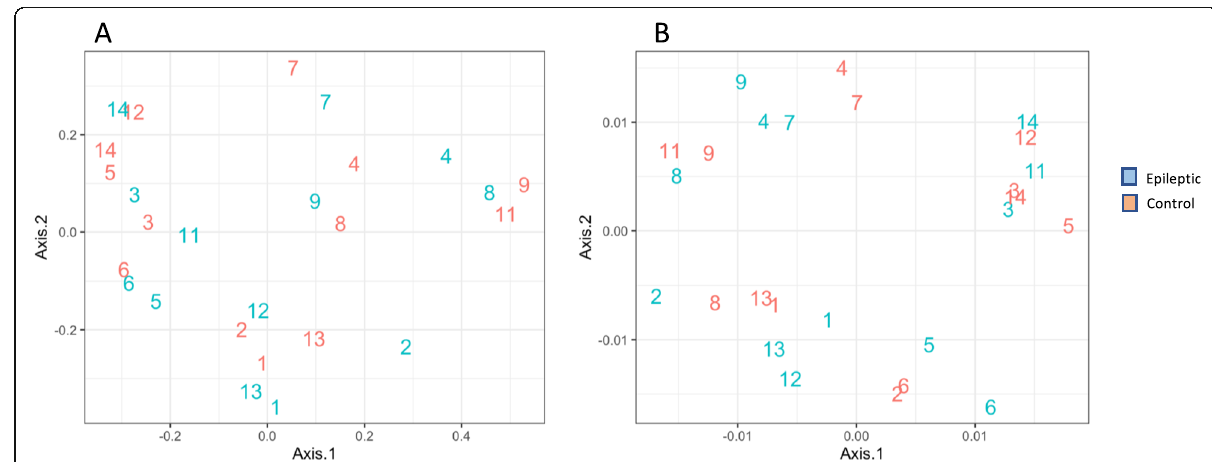
Fig. 1 Depiction of the similarity between the large-scale microbial patterns in study dogs using the Bray-Curtis ( a ) and weighted unifrac ( b ) distance metrics. Each number represents a household. In these analyses, the more similar the community pattern, the closer in proximity the data points are located. The same numbers in red and blue are seen to be in relative close proximity to one another, confirming that there is a strong household effect (Permanova, P <